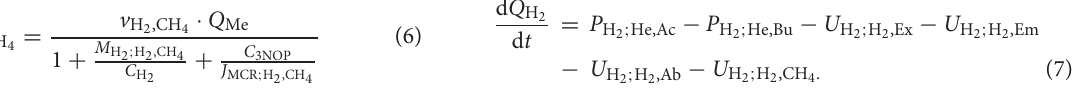
( Table 3 ). The differential equation is given